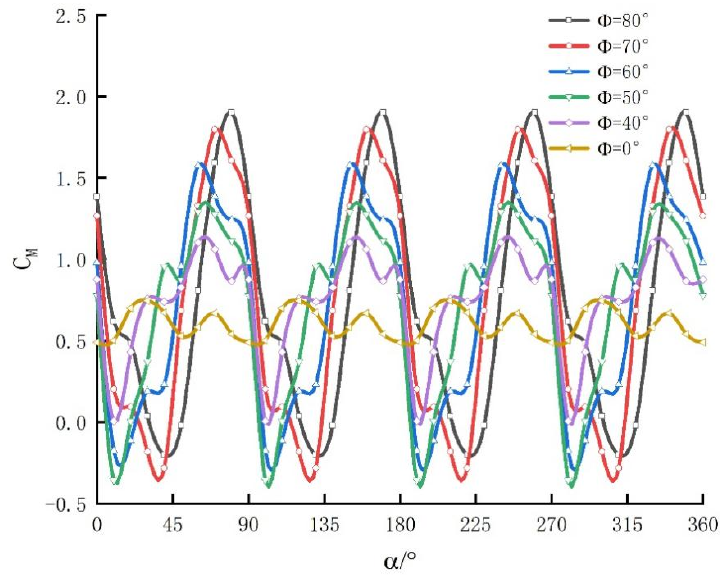
Figure 6. The torque coefficient under different open angles, Φ , changes with the angle of change.